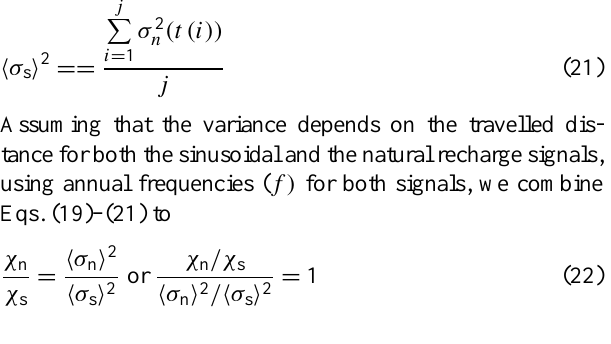
for M = 0 . 51, and larger than 0.96 for the other M